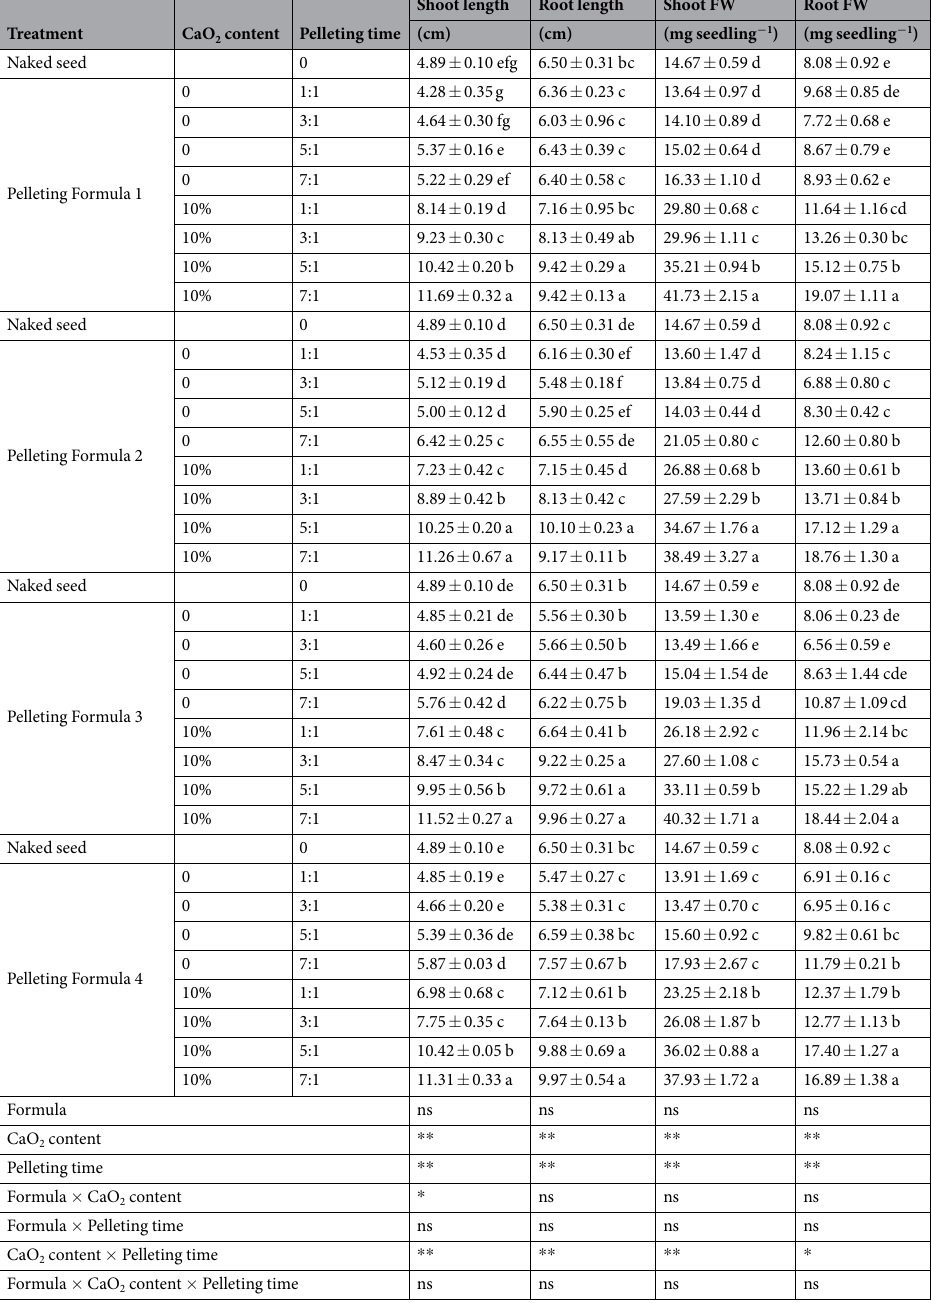
Table 2. The effect of different seed pelleting formulae with various pelleting times on seedling growth parameters of direct-seeded rice under waterlogging conditions (1.5 cm water layer) at 8 DAS in Experiment 1. Pelleting time is the weight ratio of pelleting agents to rice seeds. Within a column under each pelleting formula, means followed by different letters are significantly different at a 0.05 probability level according to a least significant difference (LSD) test. The naked seeds control were not involved in three-way ANOVA. FW: fresh weight. ** and * denote significance at the 0.01 and 0.05 probability level, respectively. ns: